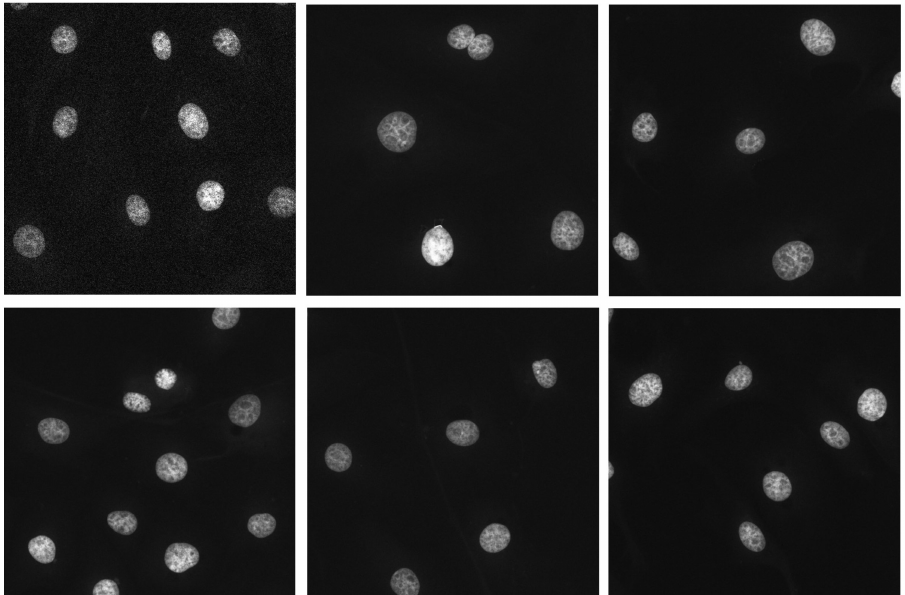
Figure 18. Some images from the FMD dataset.